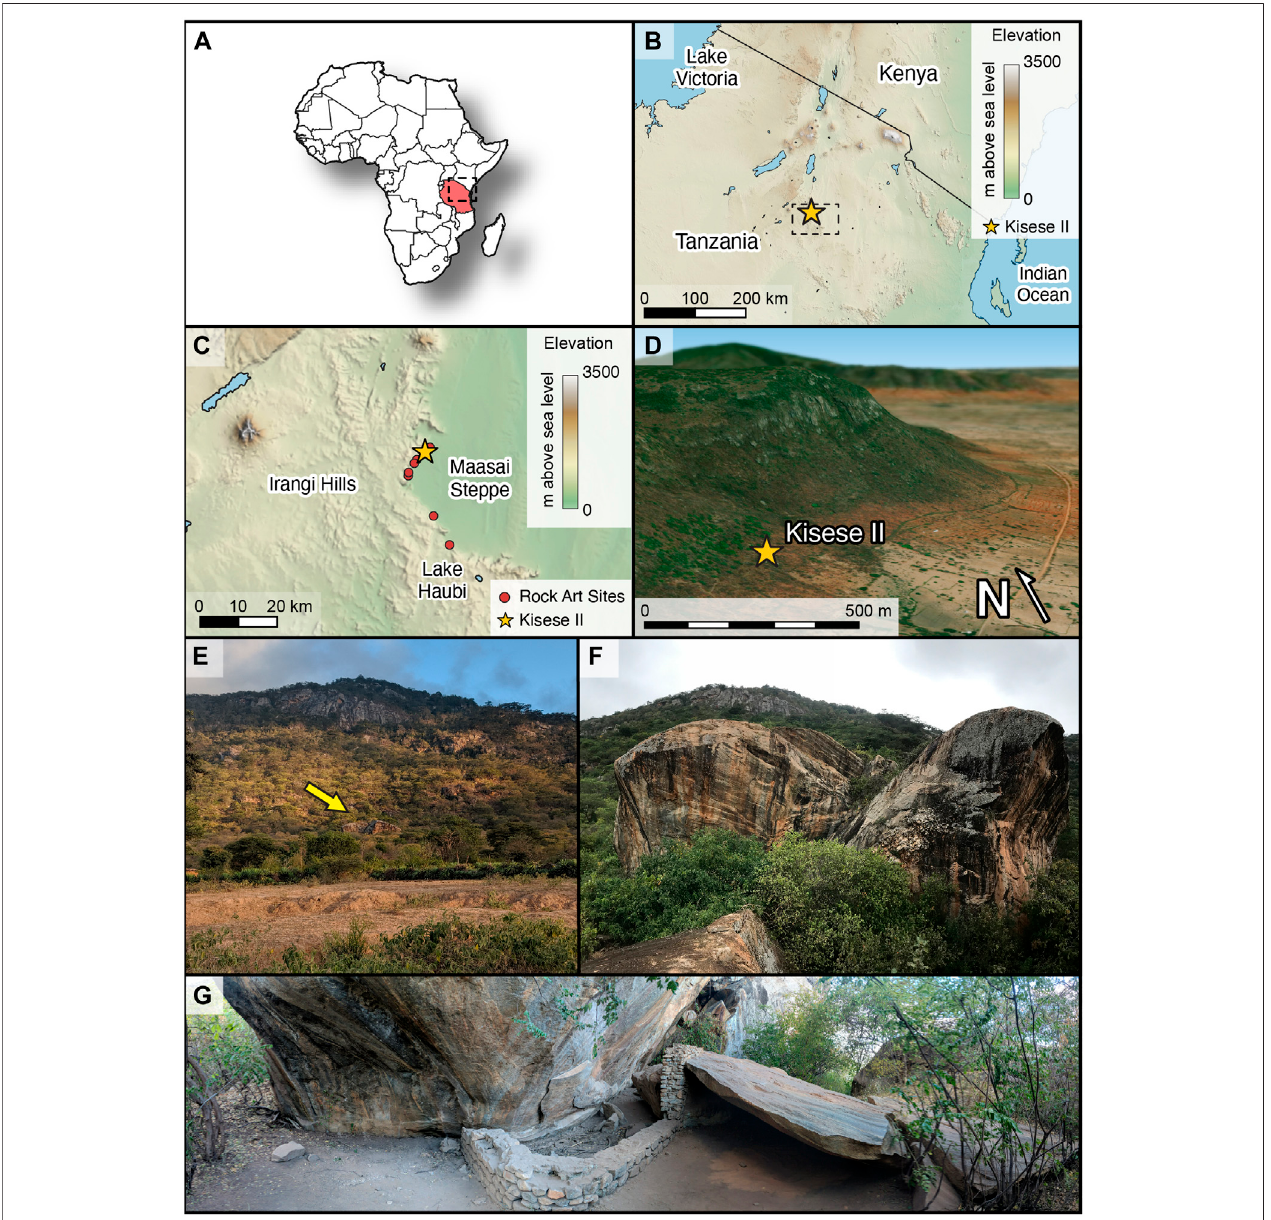
FIGURE 1 | (A) Political map of Africa with Tanzania and the area shown in (B) indicated by a dashed line. (B) Geographic location of Kisese II rockshelter (marked by the star) and the area shown in (C) indicated by a dashed line. (C) Close upof the area with the location ofKisese IIand other rock art sites identi fi ed by the UNESCO World Heritage Centre (red dots). (D) Position of Kisese II on the slope of the Irangi Hills. View facing NE. Image generated with the BlenderGIS addon for Blender. (E) View of the site (indicated by an arrow) taken from the downslope facing northwest. (F) . Detail of the two large boulders sheltering the Kisese II site taken from the smaller front boulder and facing northwest. (G) Panoramic image of the archaeological site taken in 2019 showing the location of the shelter, slabs, small boulder, and modern wall.